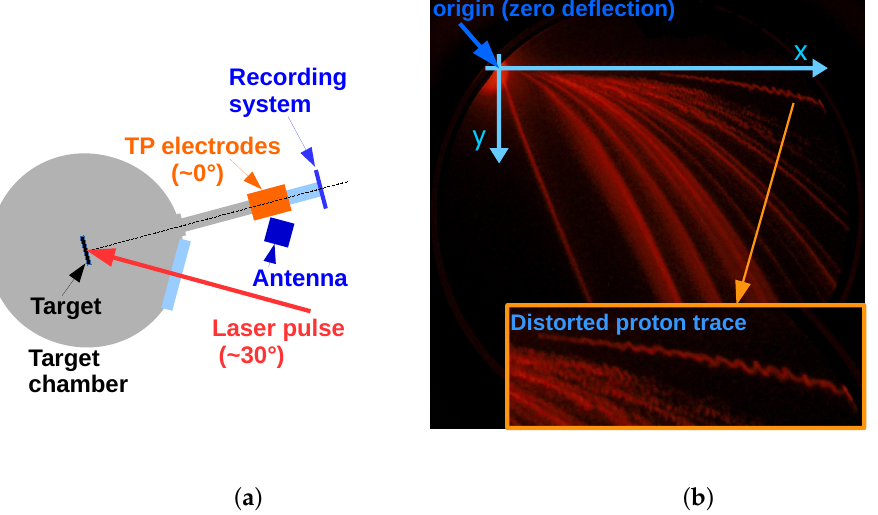
Figure 2. ( a ) Experimental setup at PALS laser facility showing position of the TP spectrometer and plane antenna. ( b ) Typical TP snapshot showing the parabolic track of protons distorted due to the electromagnetic pulse (EMP) in the Cartesian coordinate